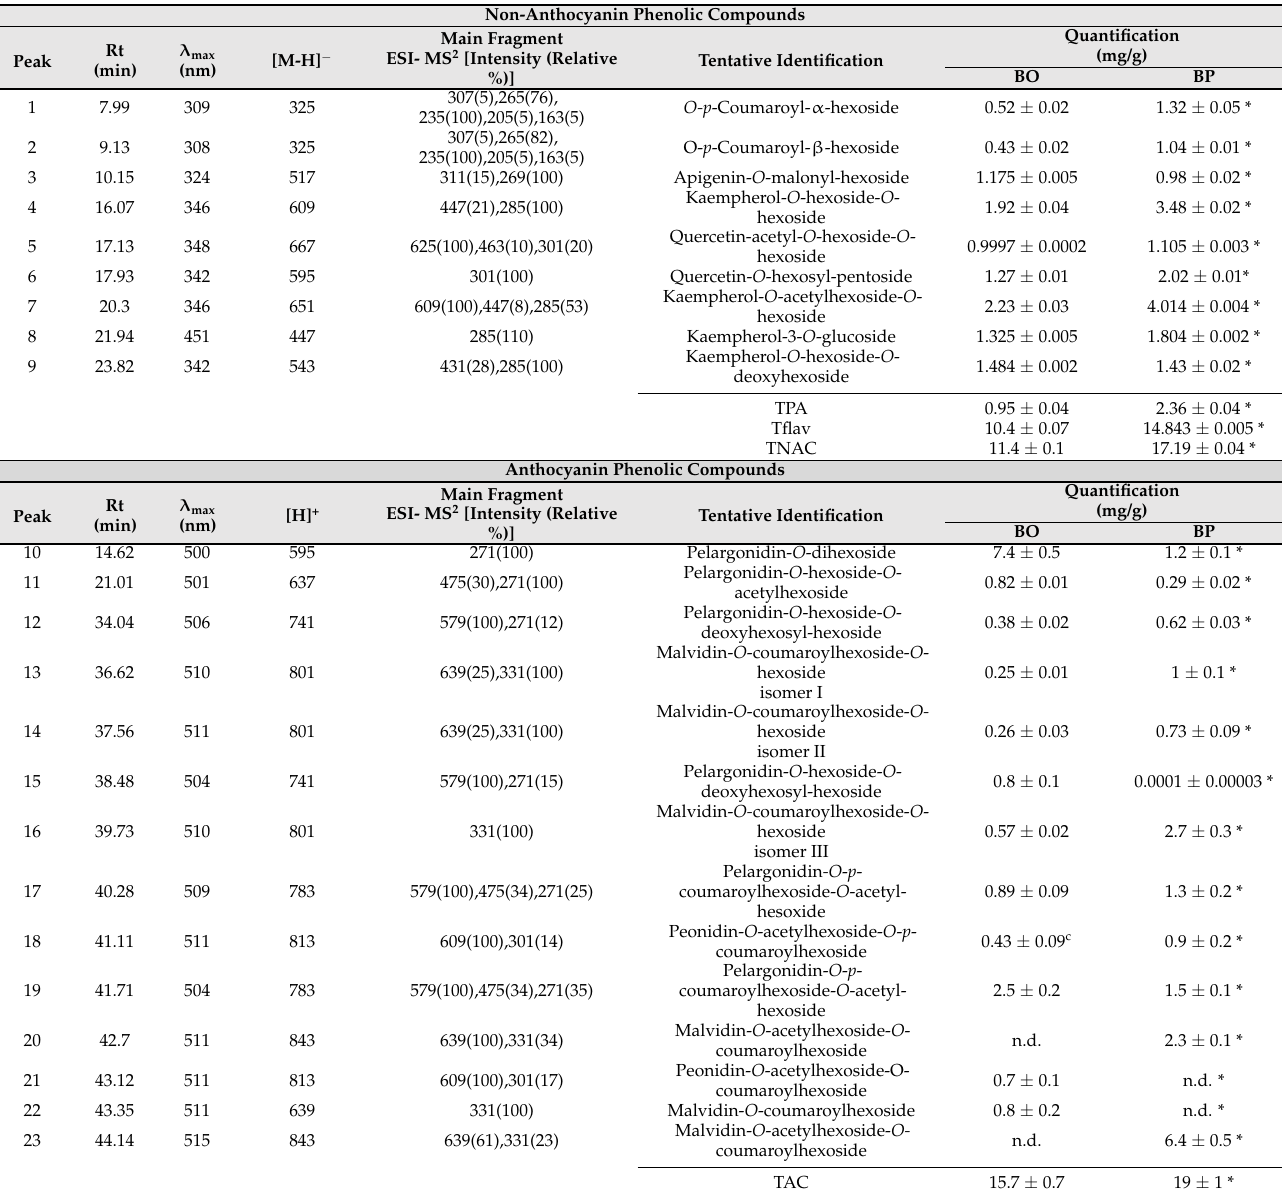
Table 2. Retention time (Rt), wavelengths of maximum absorption in the UV-Vis region ( λ max), tentative identification and quantification of phenolic compounds in Impatiens balsamina L. (orange_BO and pink_BP) hydroethanolic extract (mean ±